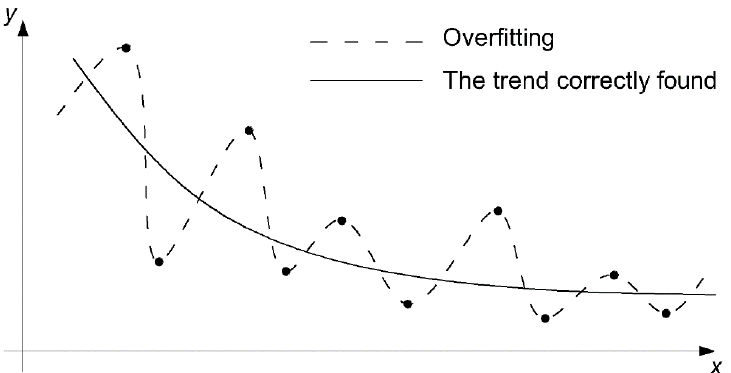
Figure 11. Overfitting predictions and the trend correctly found [28].